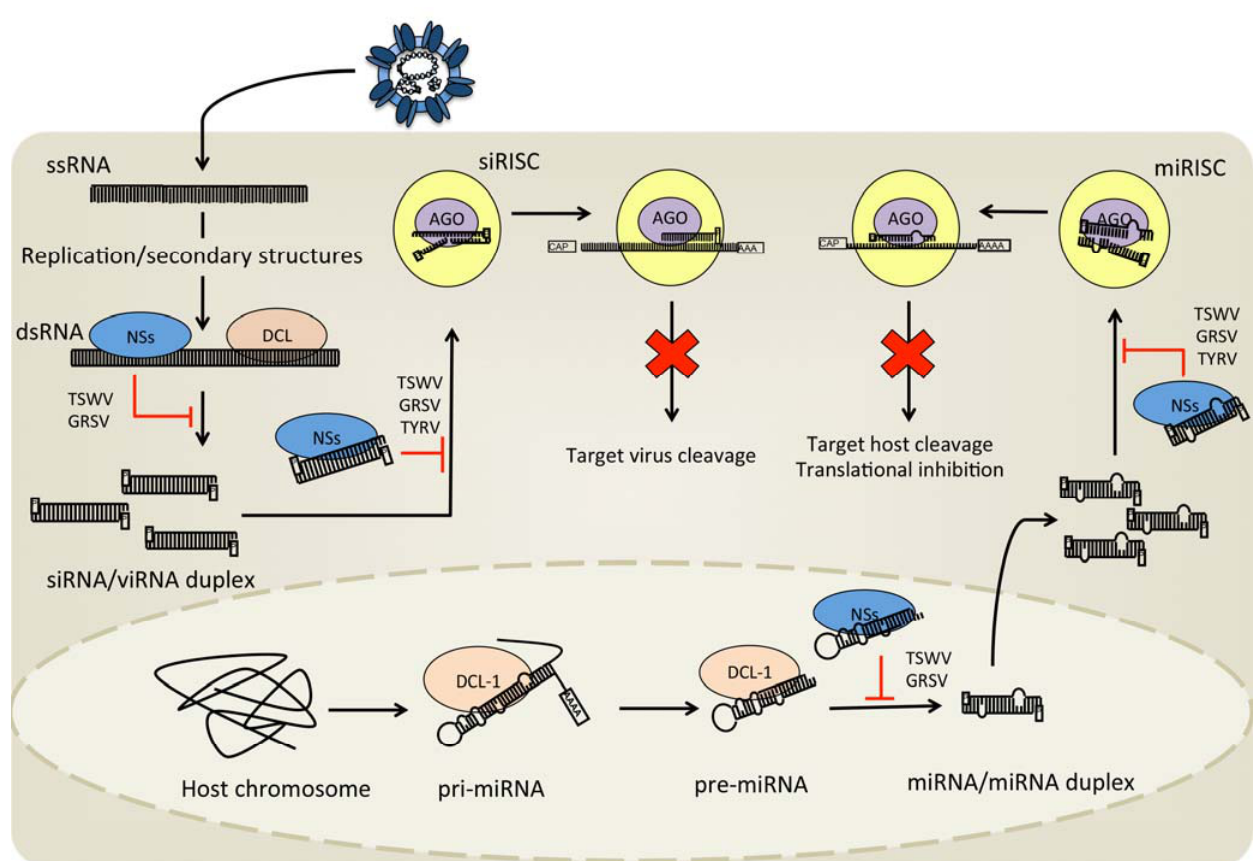
Figure 4. Tospovirus NSs interaction with the RNAi pathway in plants. Upon infection of tospovirus in plants siRNA/viRNA pathways are activated as a response to the viral dsRNA. This pathway activation leads to specific cleavage of viral RNA. The miRNA pathway is activated by expression of endogenous primary miRNA transcripts and can lead to translational inhibition and cleavage of host mRNA. This figure illustrates where the NSs of different tospoviruses act in order to interfere with these small RNA pathways of the